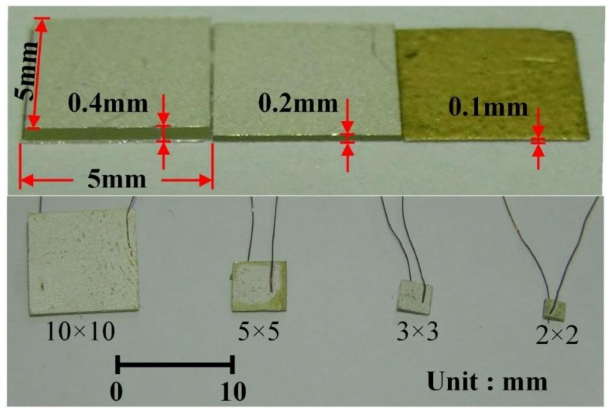
Figure 1. The fabricated PZT cells with various